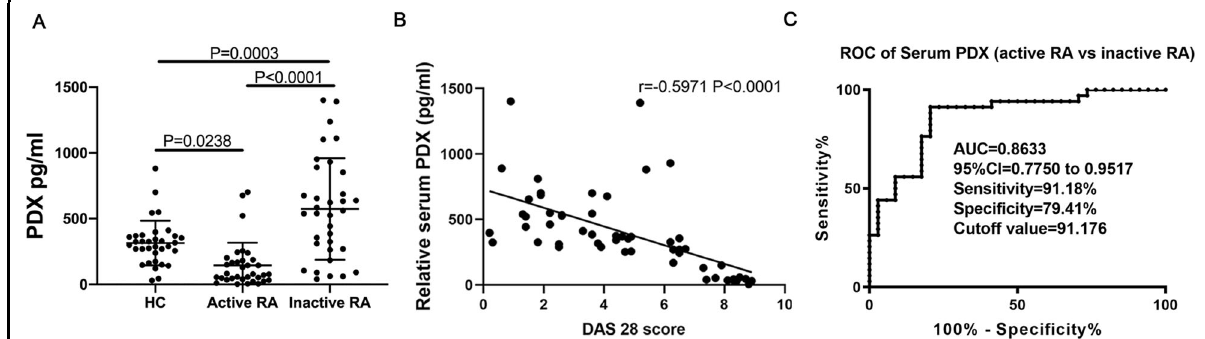
Fig. 1 Concentrations of PDX in active- and inactive-RA patients and in HCs. A Levels of PDX in serum samples from HCs ( n = 34), patients with inactive RA ( n = 34), and patients with active RA ( n = 34; F[3,102] = 22.97). B Correlation between serum PDX level and DAS28 score ( n = 54). C ROC curve analysis was performed to analyze the diagnostic value of serum PDX expression levels in active RA. Data were presented as means ± SD. Differences among the three groups were assessed by one-way ANOVA, and post hoc tests (Tukey ’ s method) were applied to investigate the differences one by